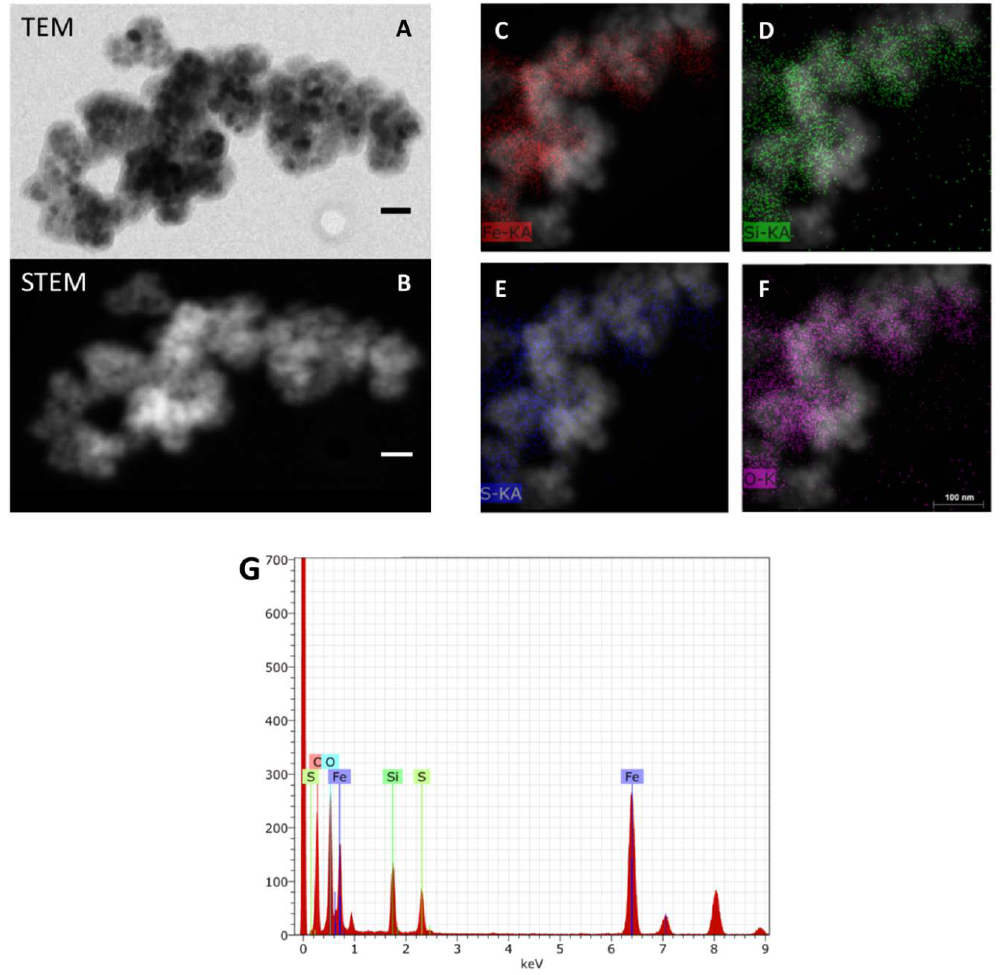
Figure 3. ( A ) TEM image of MPTS@MCNP (scale bar 100 nm); ( B ) STEM image of MCNP@MPTS (scale bar 100 nm); ( C – F ) EDX mapping of Fe, Si, S, and O obtained from the respective particles; ( G )